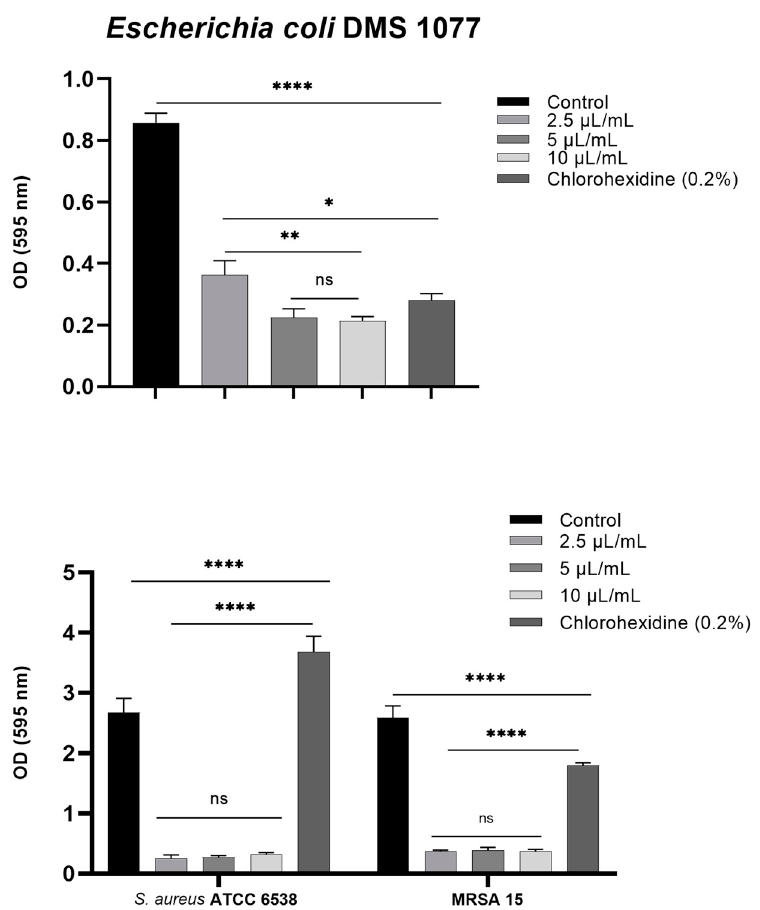
Figure 5. Impact of the combination Ro:La:Ca at ratio 0.16:0.16:0.67 on bacterial biofilm formation. Data are the mean of three independent experiments (n = 12). Error bars represent the standard deviation. * p < 0.05; ** p < 0.01; **** p < 0.0001, ns—not significant.